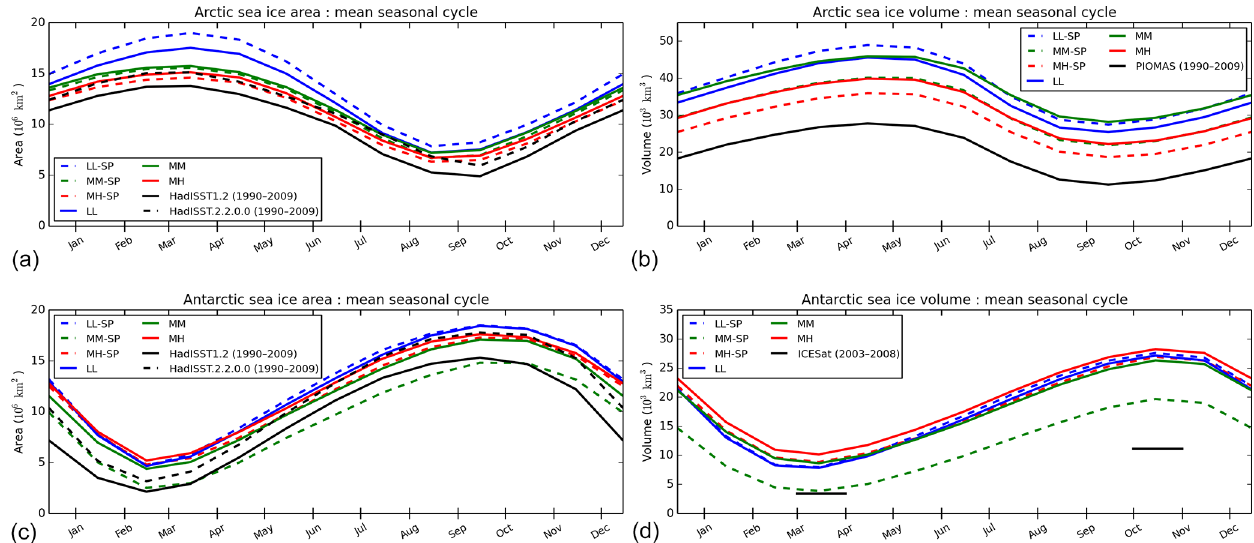
Figure 6. Seasonal cycles for (a, c) sea ice area and (b, d) sea ice volume from models and observations, in the (a, b) Arctic and (c, d) Antarctic regions. The dashed and solid colours refer to different model periods (dashed is the 10-year mean at the end of spinup-1950; solid is the 20-year mean at the end of control-1950). Observed sea ice area is from HadISST1.2 (1990–2009) and HadISST2.2.0.0 (1990– 2009), and sea ice volume is from the Pan-Arctic Ice Ocean Modeling and Assimilation System (PIOMAS) model (1990–2009) and ICESat